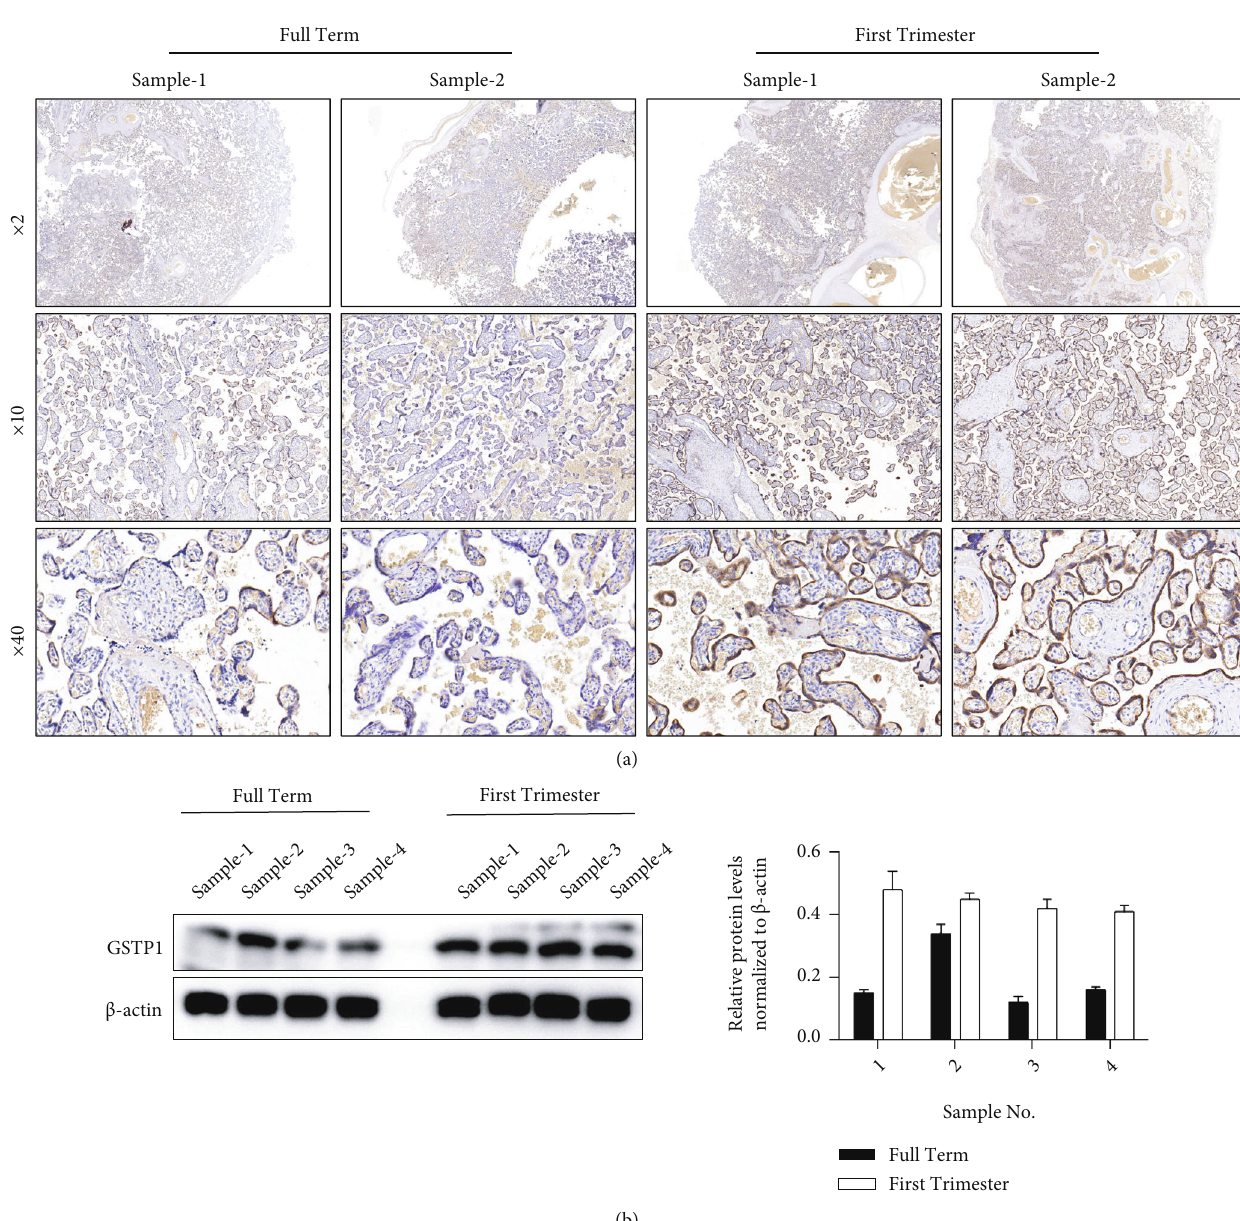
Figure 1: Detection of GSTP1 protein in fi rst-trimester villi and full-term placenta tissues. (a) Placenta tissues collected from fi rst-trimester villi or full-term patients were detected by performing ISH to evaluate the e ff ects of GSTP1 protein. (b) Fresh placenta tissues were lysed and detected by performing western blot to detect GSTP1 protein